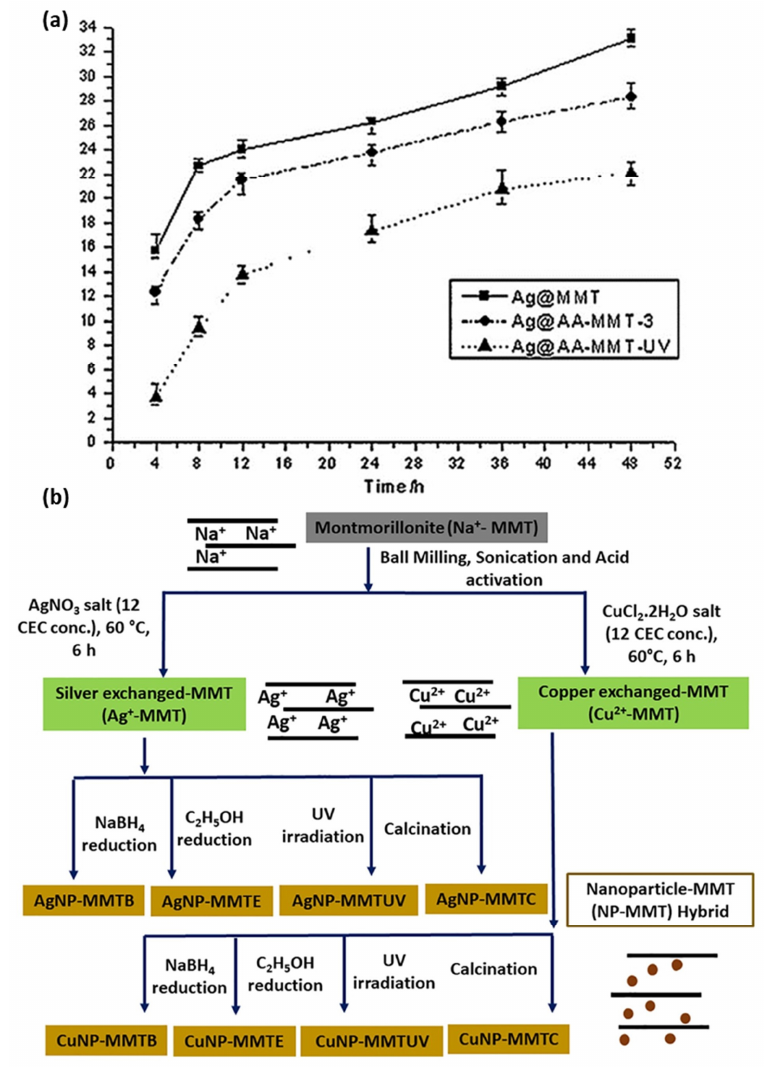
Figure 3. ( a ) Comparison of silver release properties of Ag@MMT, Ag@AA-MMT-3 and Ag@AA- MMT-UV. Adapted from [186] with permission from Elsevier (Copyright 2014). ( b ) Preparation protocol followed for synthesis of Ag/MMT and Cu/MMT nanohybrids. Adapted from [31], with permission from Elsevier (Copyright 2018).